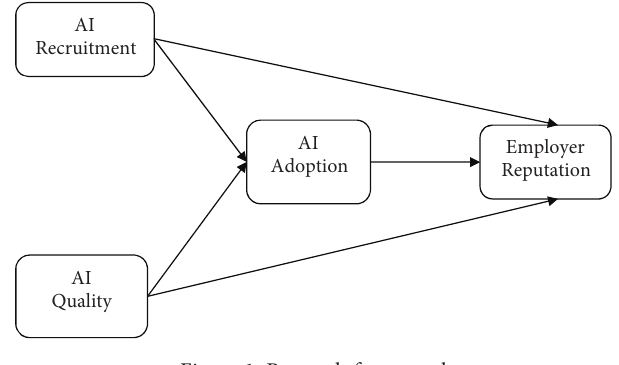
Figure 1. Research